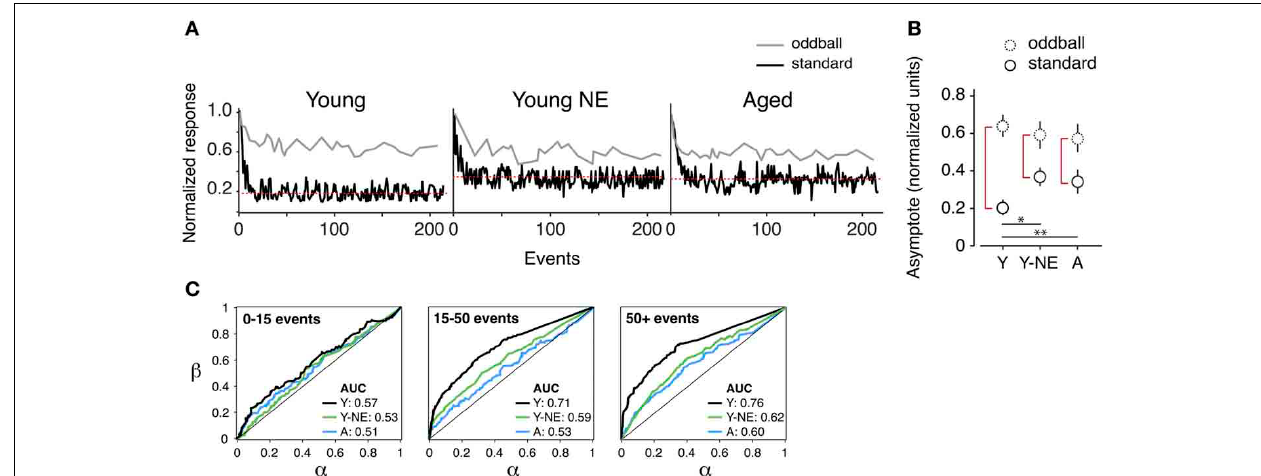
FIGURE 4 | Reduced deviant tone detection by A1 neurons in the noise-exposed group. (A) Representative normalized responses of individual A1 neurons in the three experimental groups to standards (black line) and deviant tones or “oddballs” (gray line) as a function tone position in the stimulus sequence. The red dotted line represents the asymptote of the progressively suppressed response to standards. (B) Average asymptote computed for the response to oddballs and standards in all groups. Note the reduction in the difference between